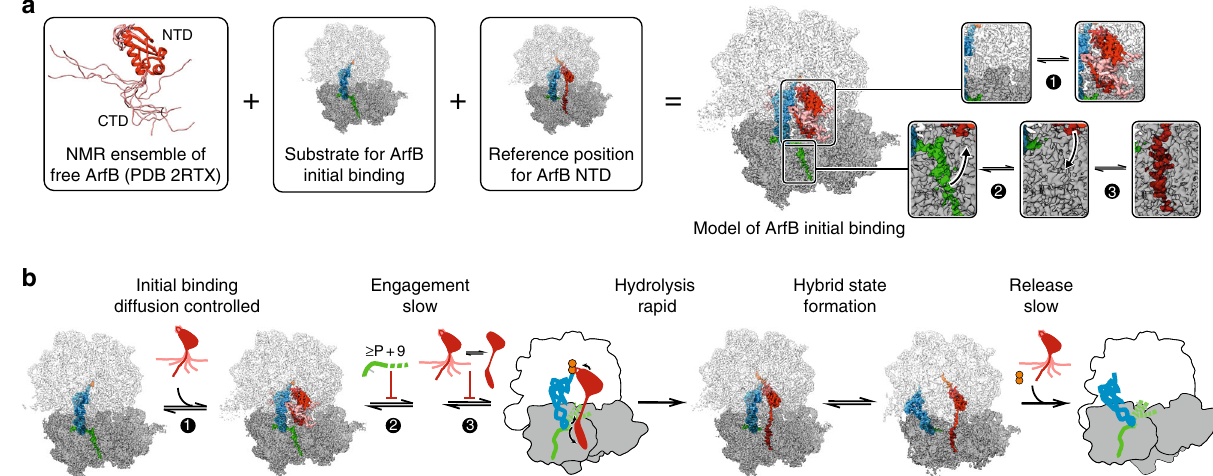
Fig. 5 Mechanism of ribosome rescue by ArfB based on rapid kinetics and cryo-EM data. a Model for initial binding of ArfB, based on the NMR ensemble of free ArfB 10 and cryo-EM structures of the P + 9 ribosome-ArfB complex. 1, 2, 3 illustrate the key steps of the mechanism. b Mechanism of ArfB action. When the ribosome stalls on a truncated mRNA, ArfB can rapidly bind regardless of the mRNA length (1). Subsequent conformational rearrangements allow the factor to probe the mRNA entry channel; if there is mRNA extending past the P site, the mRNA must fi rst move out of the mRNA entry channel (2), a process that occurs more slowly with longer mRNAs. The binding and folding of the ArfB C-terminal domain result in the engagement of ArfB on the 30S subunit (3), which allows the rapid hydrolysis reaction to occur via the GGQ motif in the PTC, followed by peptide release, ribosome rotation and movement of the tRNA into the hybrid state, and ArfB